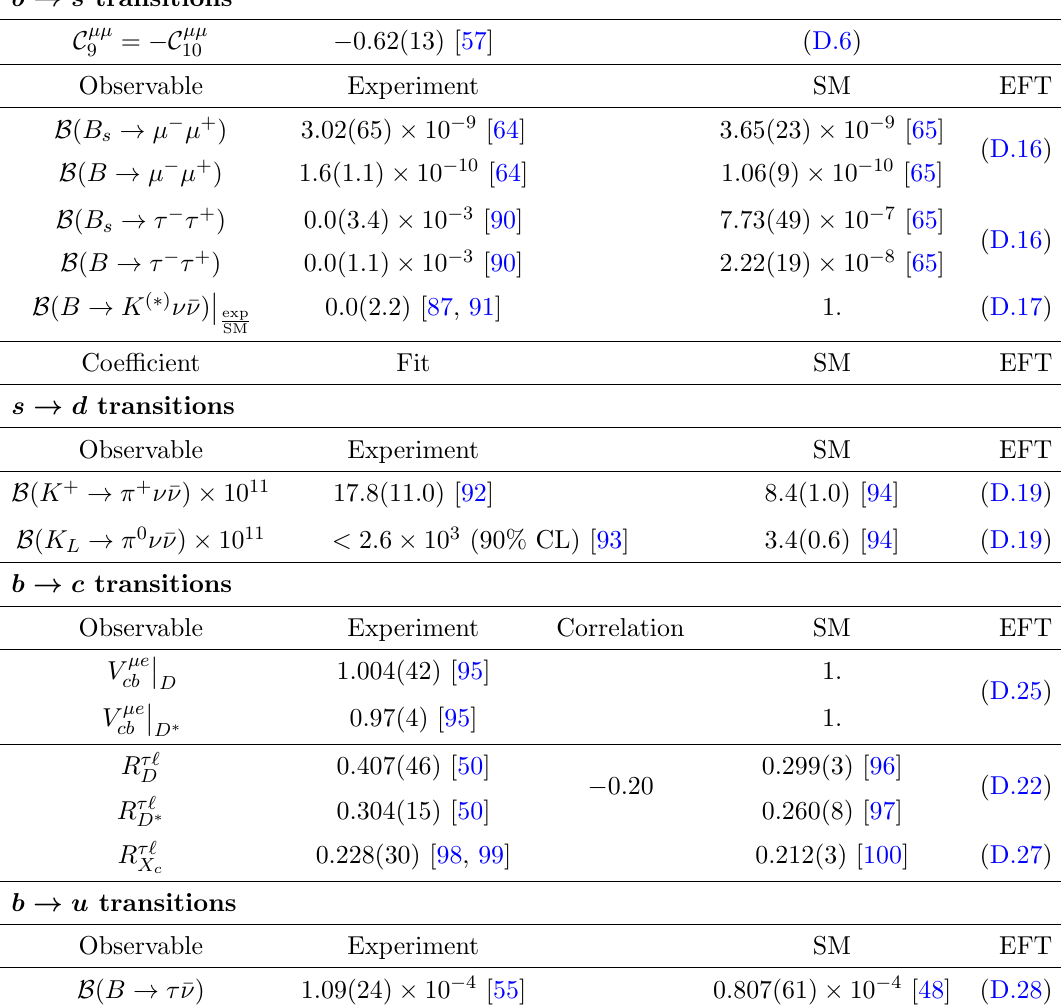
Table 10 . List of observables involving semileptonic